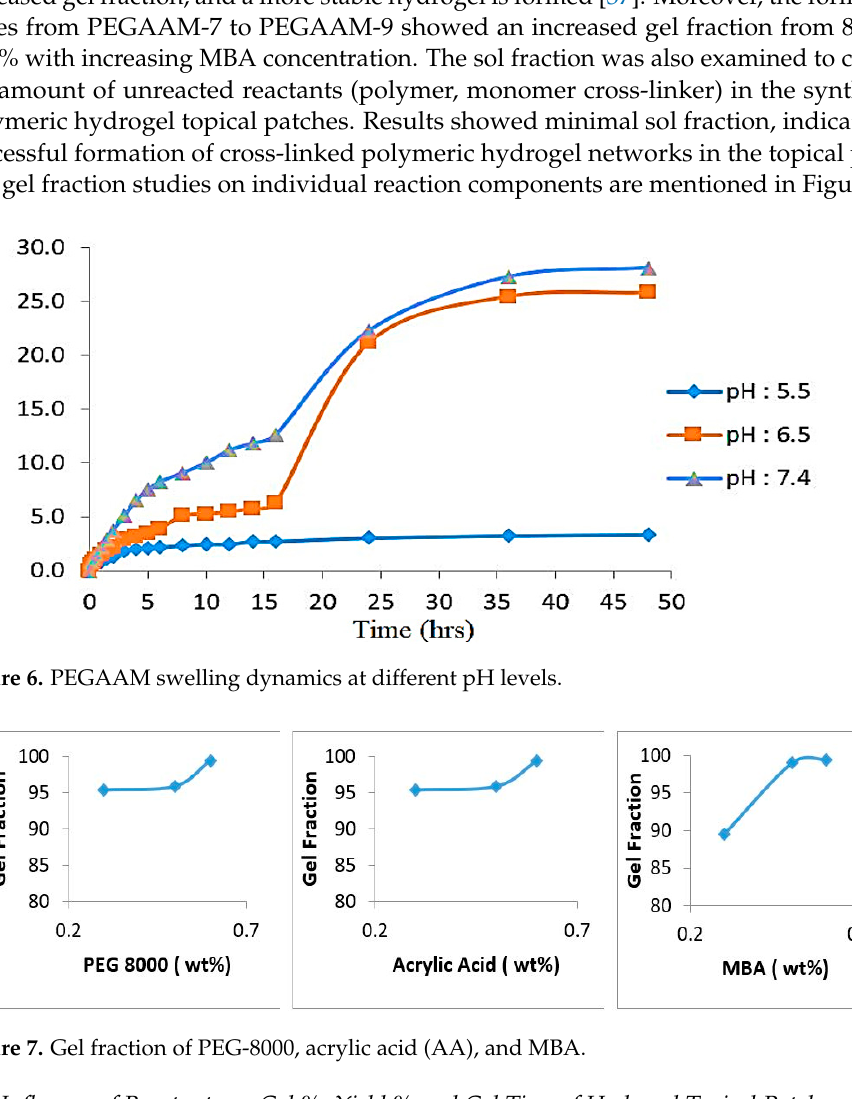
Figure 7. Gel fraction of PEG-8000, acrylic acid (AA), and MBA.